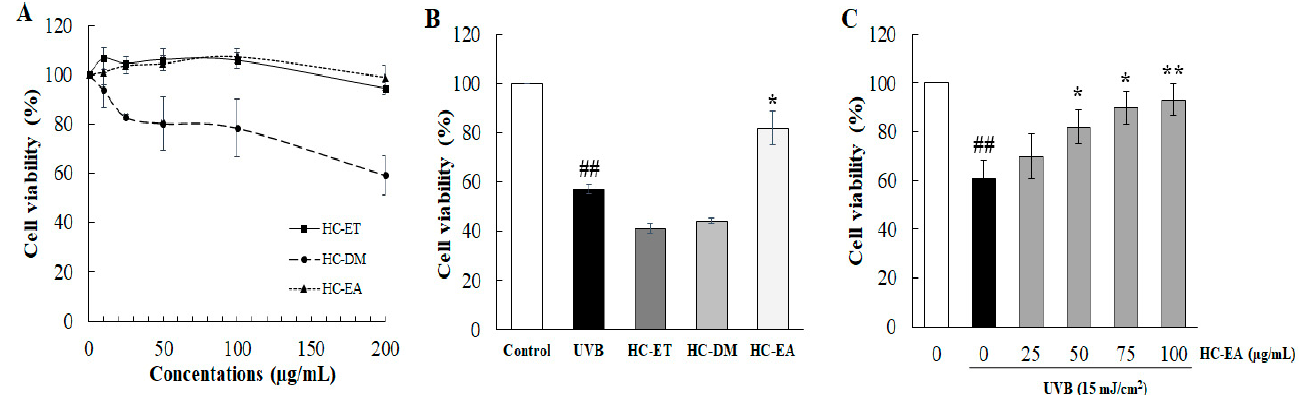
Figure 1. Effects of H. cordata extract fractions on cell viability in UVB-irradiated HaCaT cells. ( A ) HaCaT cells were treated with various concentrations of H. cordata extract fractions for 48 h and the cell viability was measured by SRB assay. ( B ) The protective effects of H. cordata extract fractions on UVB-induced HaCaT cell death. The cells were pretreated with the fractions for 6 h prior UVB irradiation (15 mJ/cm 2 ), then cell viability was measured at 24 h after UVB irradiation. ( C ) Effects of HC-EA fraction on UVB-irradiated HaCaT cells. The cells were pretreated with various concentrations of HC-EA for 6 h prior UVB irradiation (15 mJ/cm 2 ), then the cell viability was measured at 24 h after UVB irradiation. * p < 0.05, ** p < 0.01, as compared to the UVB-irradiated alone group. ## p < 0.01 as compared to the non-UV group. Data are representative of three independent experiments as mean ± SD.